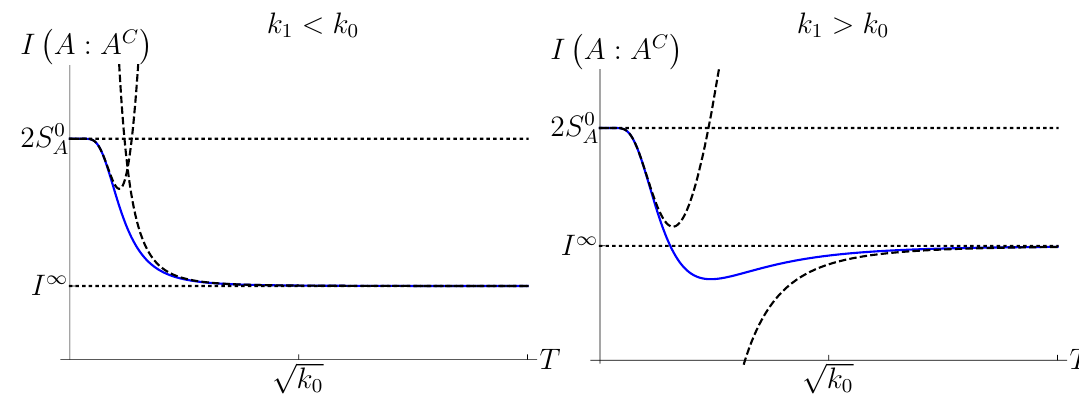
Figure 1 . The mutual information as function of the temperature. The continuous blue line is the analytic result as given by the equation (2.24). The dashed lines are the high and low temperature expansions of the mutual information, given by equations (2.36) and (2.46), respectively. The dotted lines are the asymptotic values for T ! 0 and T ! 1